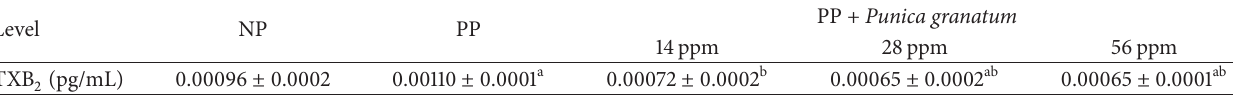
Table 2: Thromboxane B2 level in endothelial cells induced by plasma preeclamptic patients.